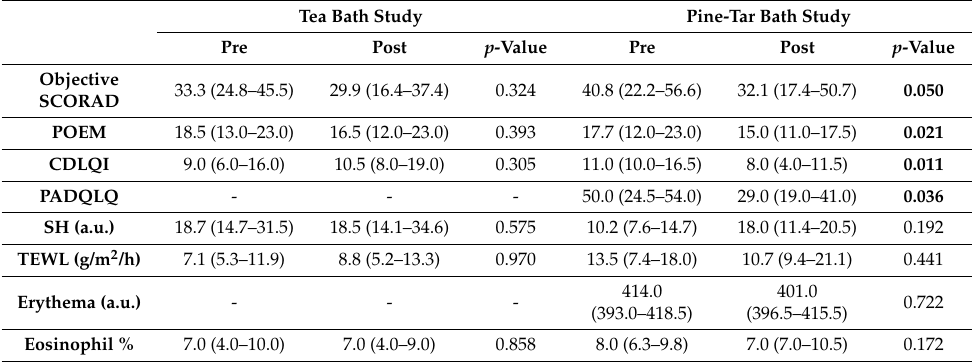
Table 2. Demographic changes pre- and post-study in the Tea bath and Pine-tar bath